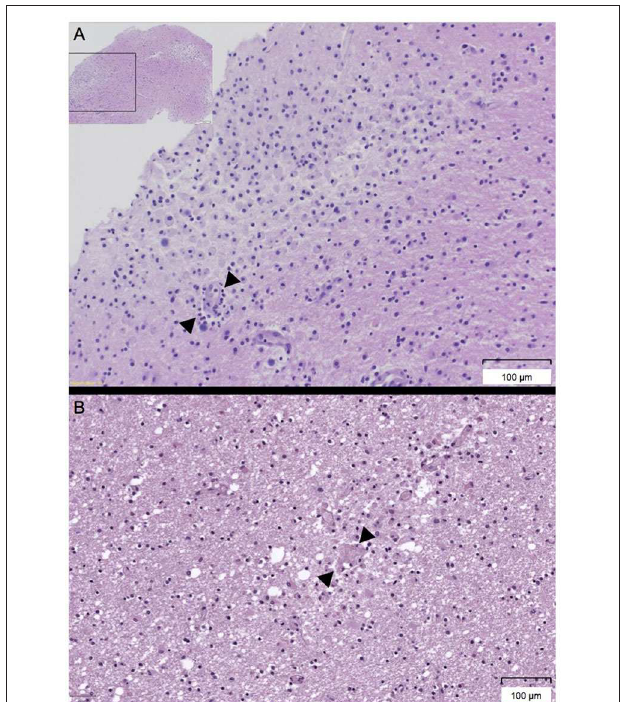
FIGURE 3 | (A,B) Histologic workup of the biopsy of the left frontal lobe and the cerebral autopsy. (A) Histology of the biopsy of the left frontal lobe showing perivascular infiltrates (arrow) of neutrophils, eosinophils, and macrophages (Hemalaun Eosin [HE] stain). (B) Histology of the cerebral autopsy revealing diffuse generalized inflammation and acute hemorrhages (arrow) (Hemalaun Eosin [HE]